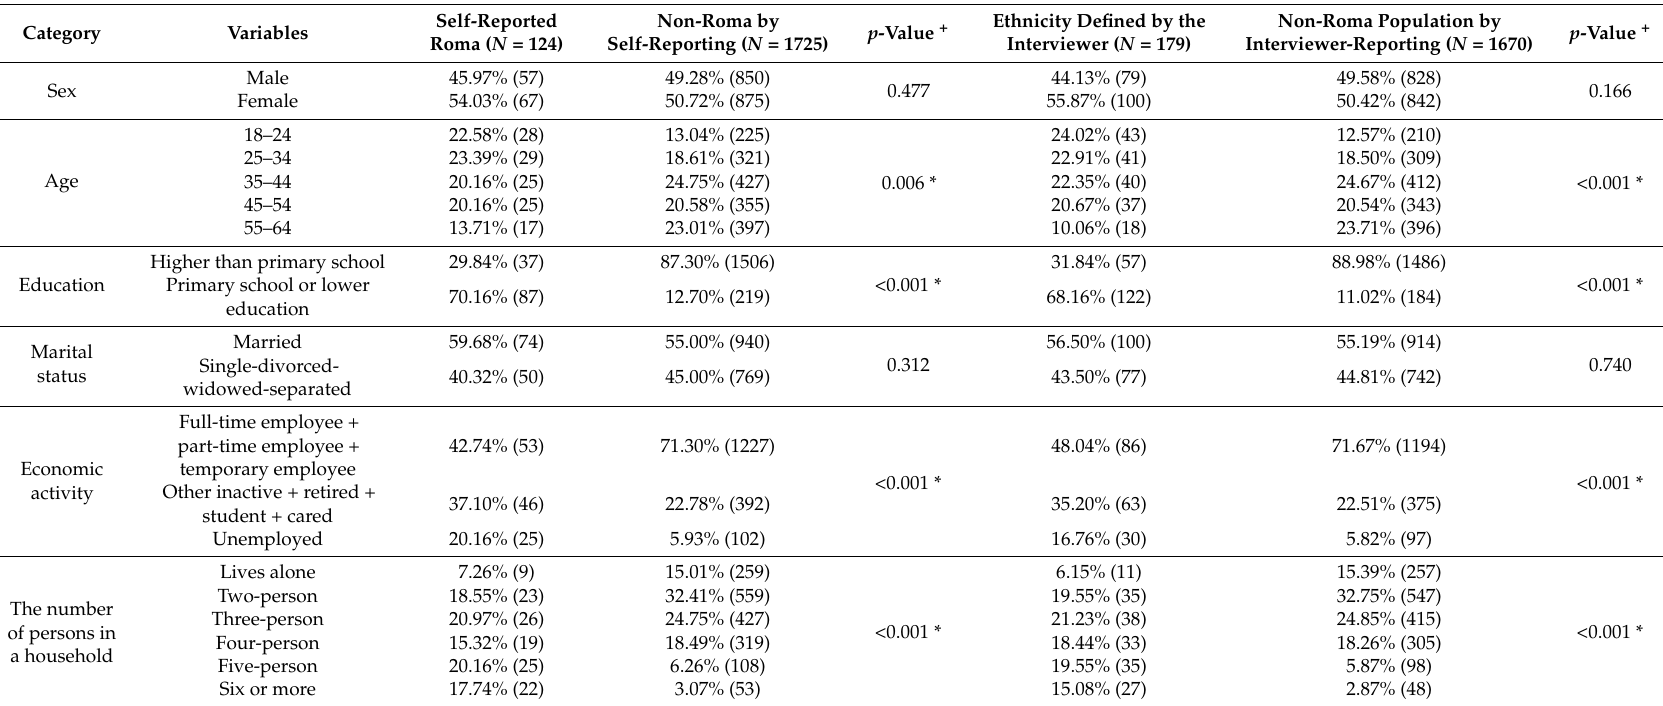
Table 1. Socio-economic status of the Roma and non-Roma